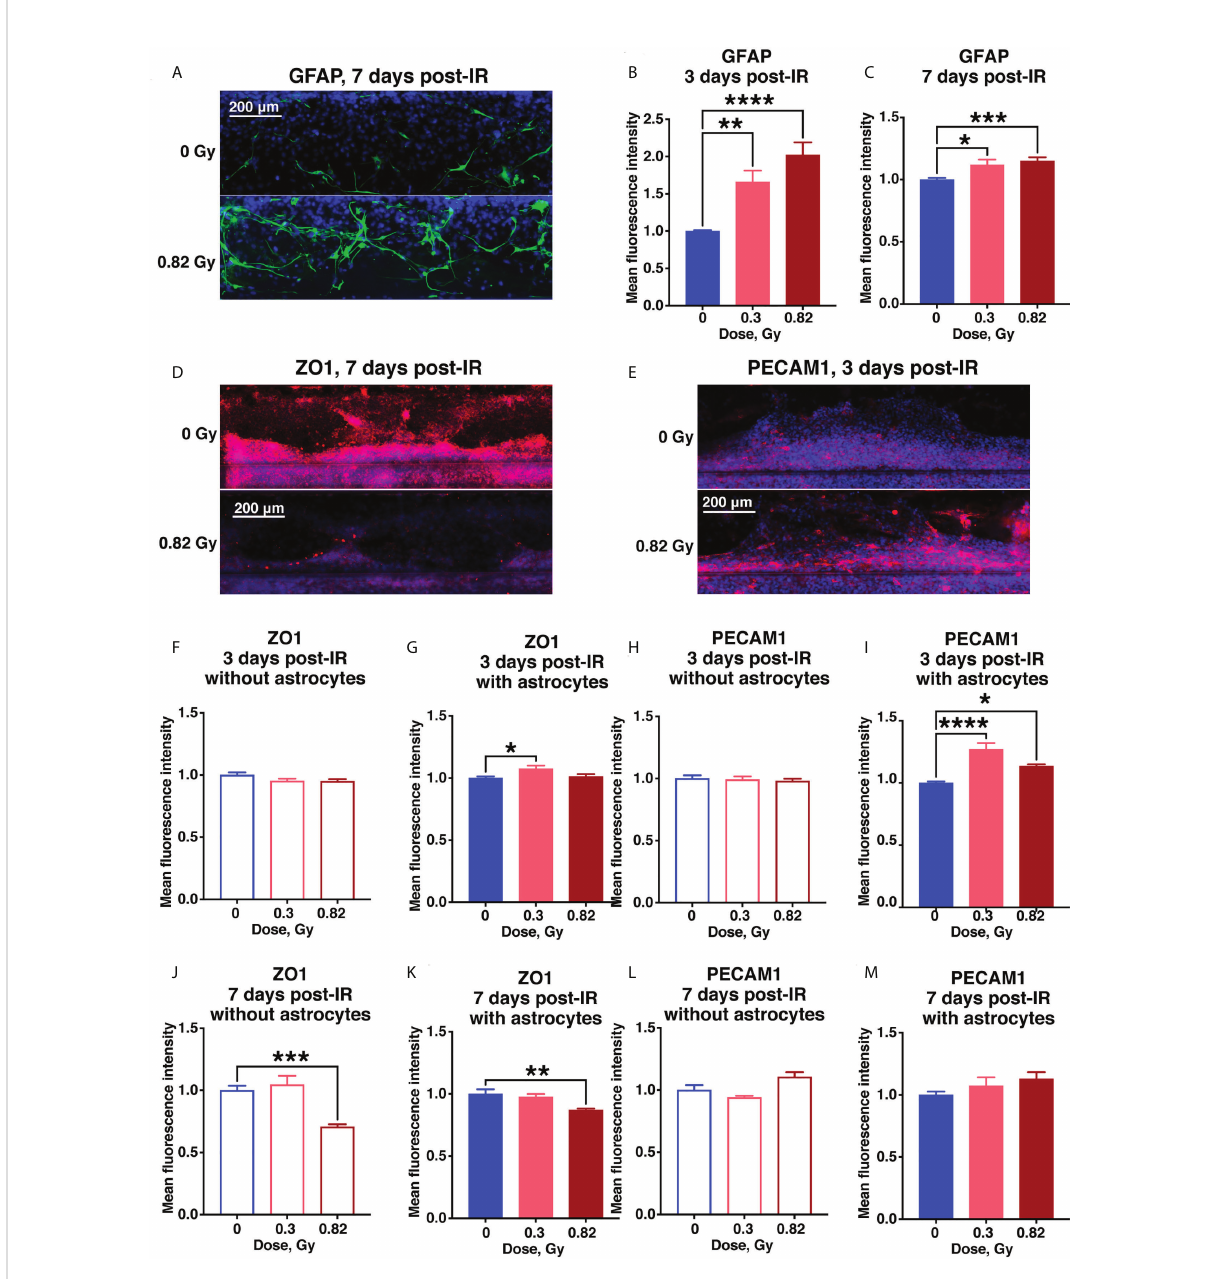
FIGURE 5 Subacute BBB damage from 600 MeV/n 56 Fe irradiation is in part mediated by activated astrocytes. (A – C) Representative images (A) and quanti fi cation (B, C) of astrocytic GFAP (green) immuno fl uorescence 3 days (B) and 7 days (C) after irradiation. (D – M) .Representative images (D, E) and quanti fi cation (F – M) of endothelial ZO1 (red) and PECAM1 (red) immuno fl uorescence 3 days (F – I) and 7 days (J – M) after irradiation. All images counterstained with DAPI, blue. Open bars, chips with endothelial cells only. Shaded bars, chips with endothelial cells and astrocytes. Blue, 0 Gy sham irradiation. Light red, lower dose (0.3 Gy). Dark red, higher dose (0.82 Gy). N = 12-24 areas from 6-12 chips per condition. Error bars, mean ± SEM. *p < 0.05, **p < 0.01, ***p < 0.001, ****p < 0.0001, 1-way ANOVA, Dunnett ’ s multiple comparisons test. Non statistically signi fi cant changes are not